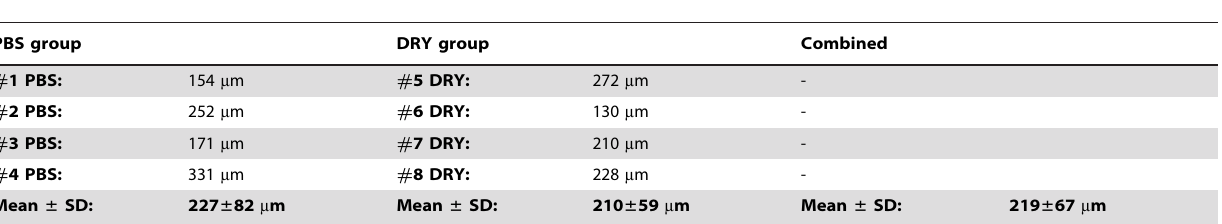
CXL zone depth corresponds to the stromal depth exhibiting 1.4-fold stiffening.